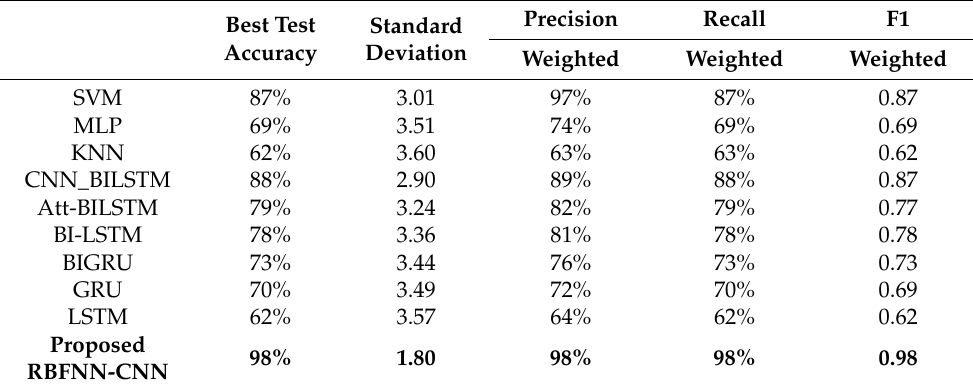
Table 2. Average speaker identification performance using Emirati accent dataset.